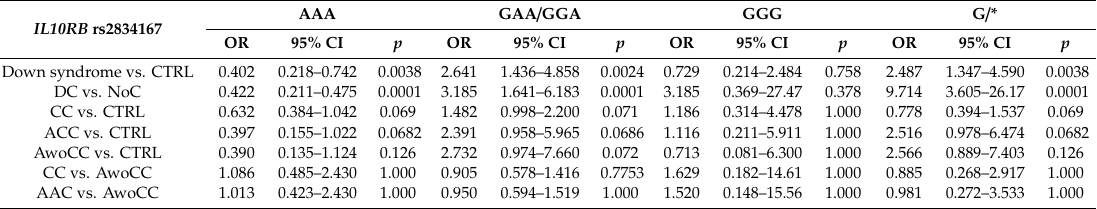
Table 8. Statistical analyses of di ff erences in genotype frequencies between patient with DS and controls. AAA GAA / IL10RB rs2834167